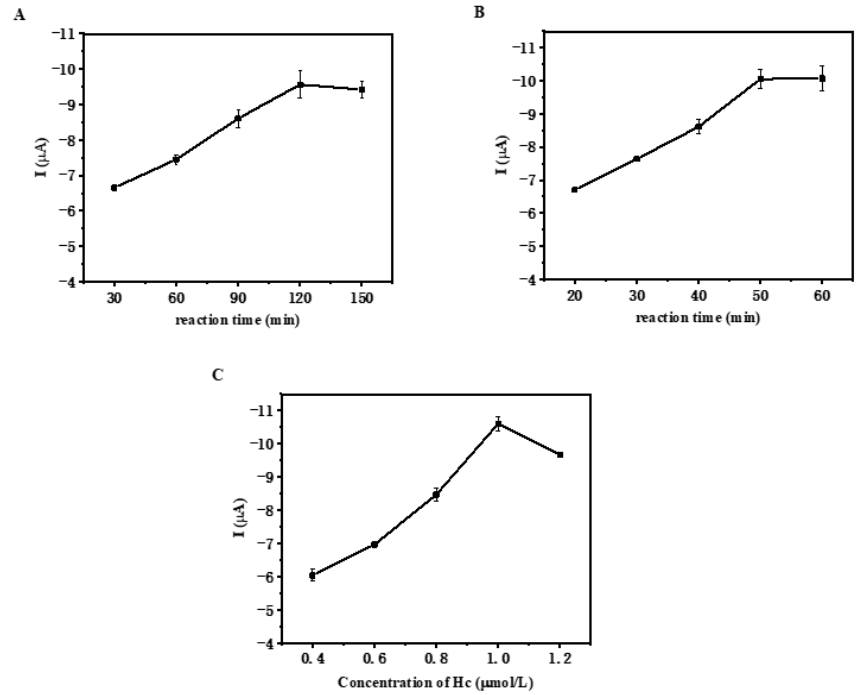
Figure 3. Optimization of the assay conditions: ( A ) DNA strand incubation time. ( B ) reaction time of EXO III. ( C ) Concentration of HC. When one experimental condition changed, the others were under their optimal conditions. The standard deviation of three parallel measurements is shown by the error bars.